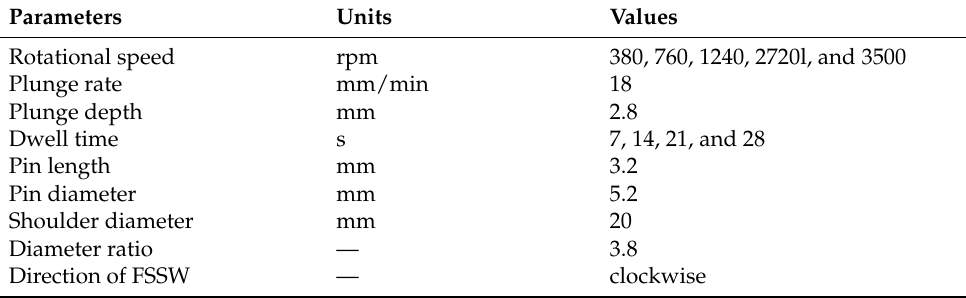
Table 3. Essential parameters and tool dimensions in FSSW